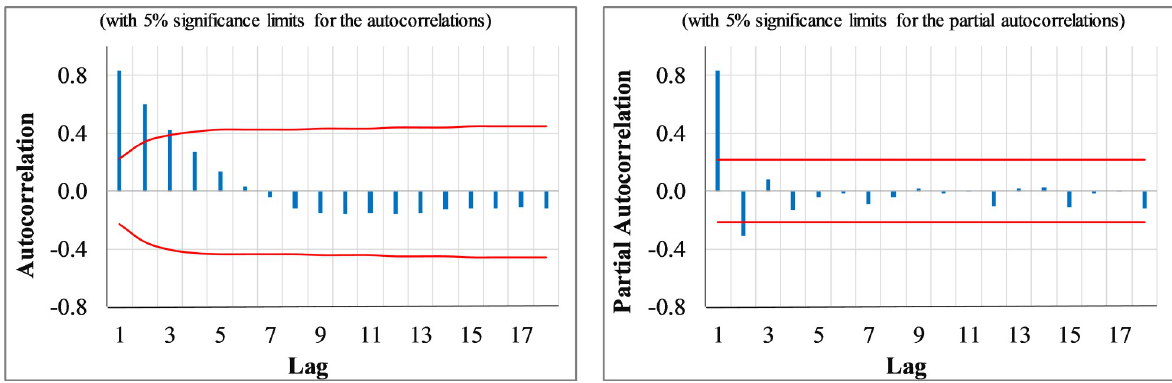
Fig 2. The ACF and PACF plots of the log-transformed weekly intercity traffic time series.